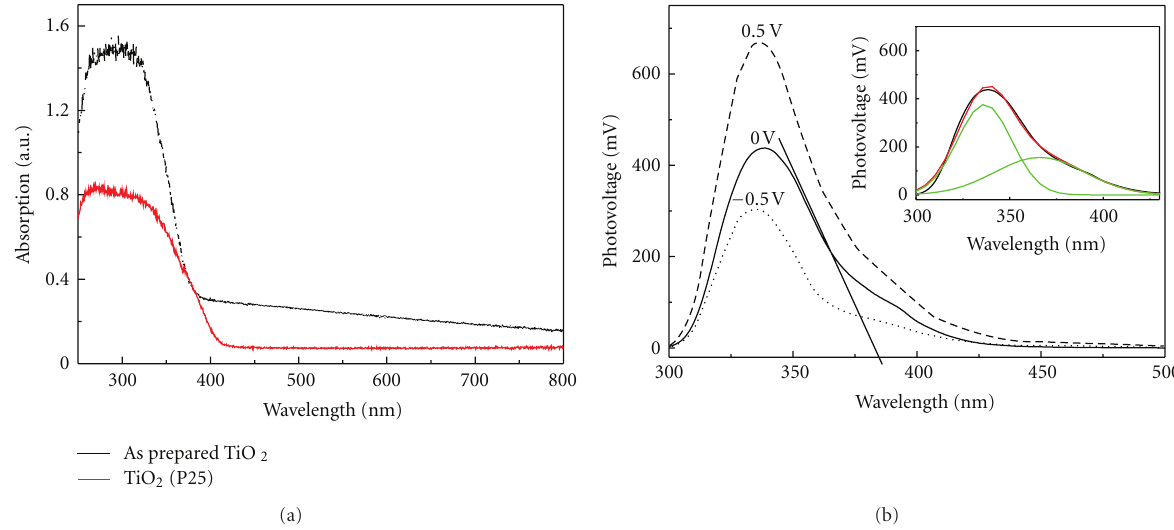
Figure 6: (a) UV-Vis di ff use reflection absorption spectra of the as-prepared mesoporous TiO 2 and P25. (b) Surface photovoltage spectrum (SPS) and field-induced surface photovoltage spectra (FISPS) of the mesoporous TiO 2 , and the inset is the Gaussian fitting of the